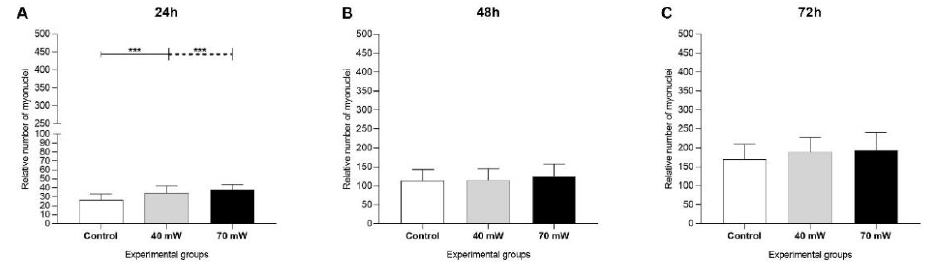
Figure 2. Proliferation of C2C12 myoblasts submitted to LLL after ( A ) 24 h, ( B ) 48 h, and ( C ) 72 h (ANOVA/Tukey); *** p < 0.001 .